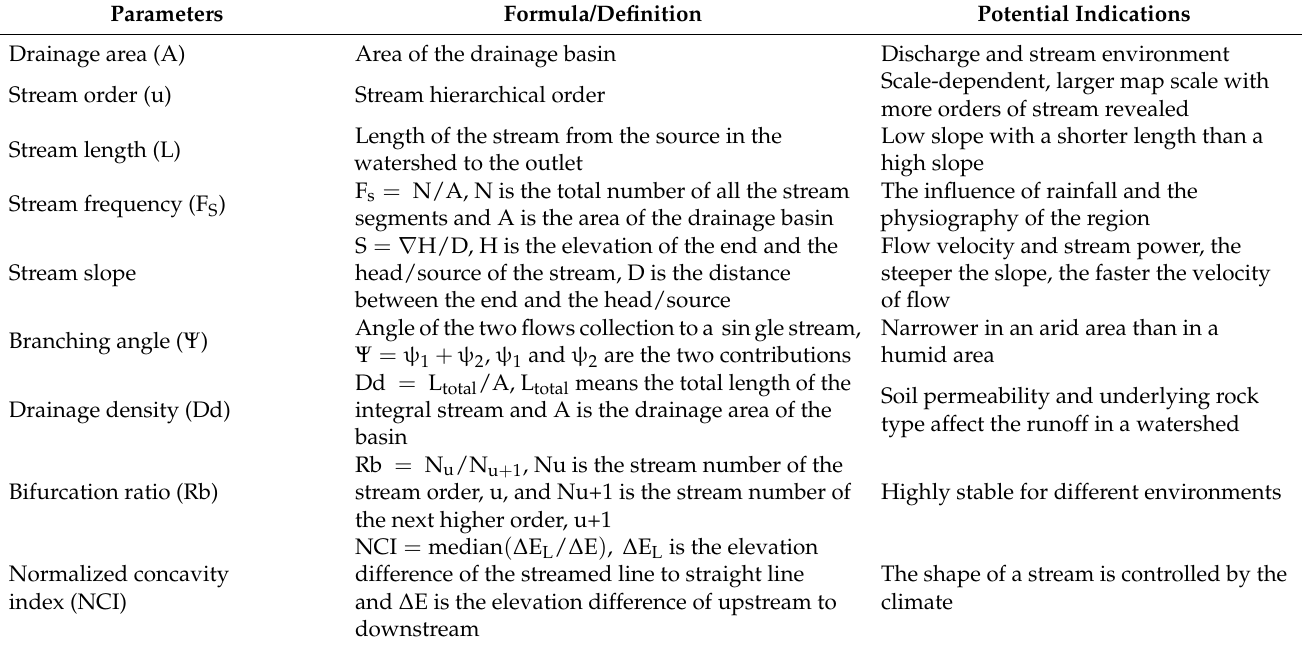
Table 2. Formula and definition of morphometric parameters of a drainage